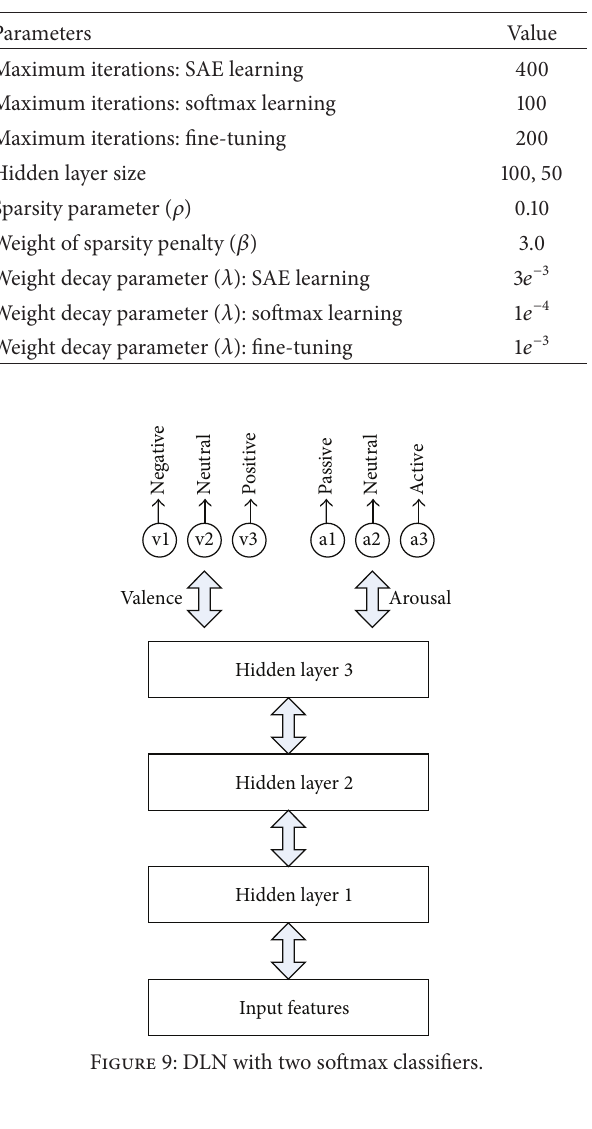
Table 1: DLN parameter settings.